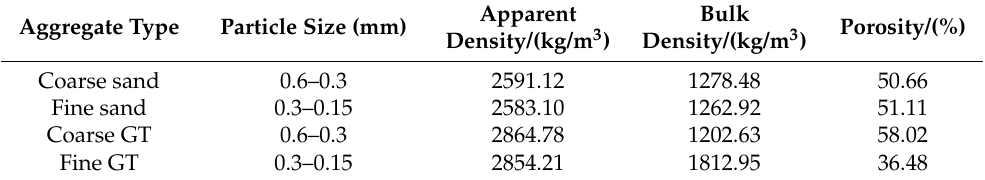
Table 5. Physical parameters of